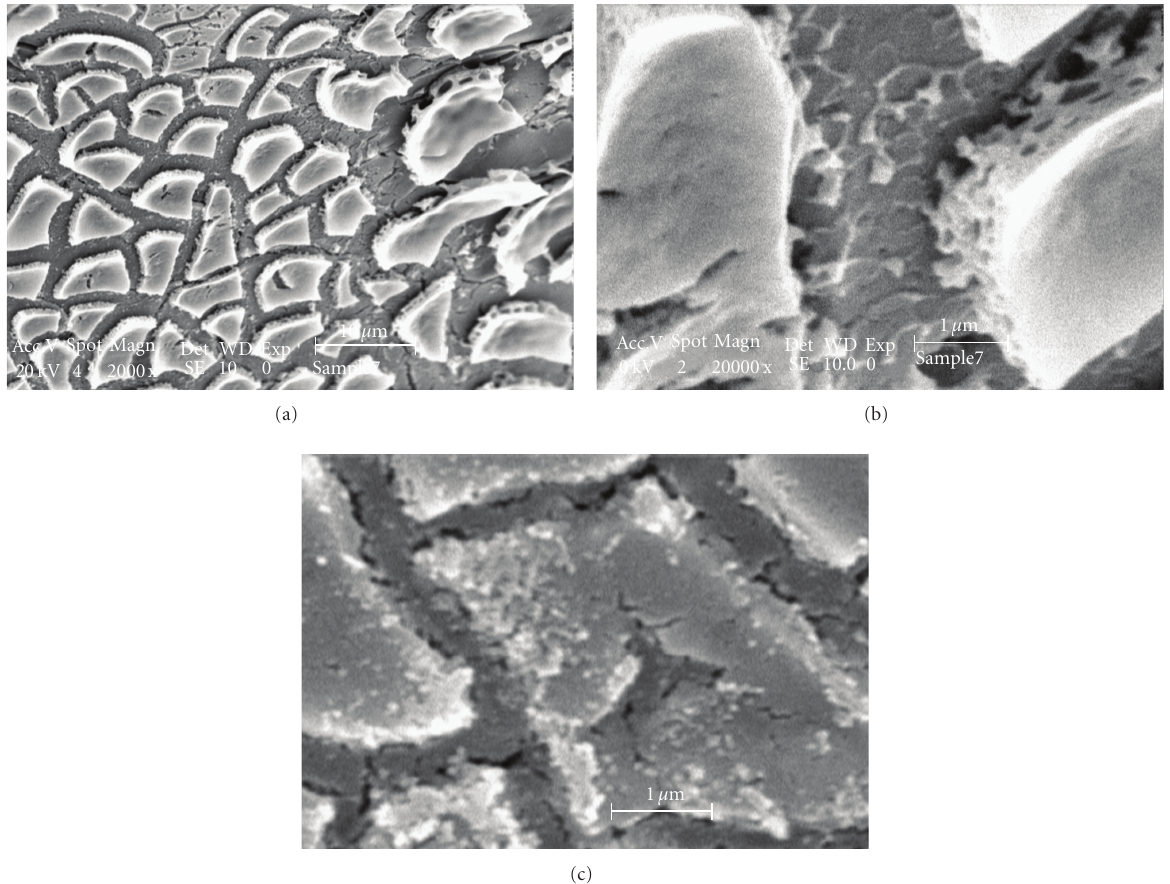
Figure 12: SEM images of (a) and (b) deactivate Ti / SnO 2 -Sb (Sb:Sn of 100 :2) electrode at di ff erent magnifications and (c) deactivated Ti/SnO 2 -Sb-Ni (Sn:Sb:Ni of 100 :2:0.2) electrode.